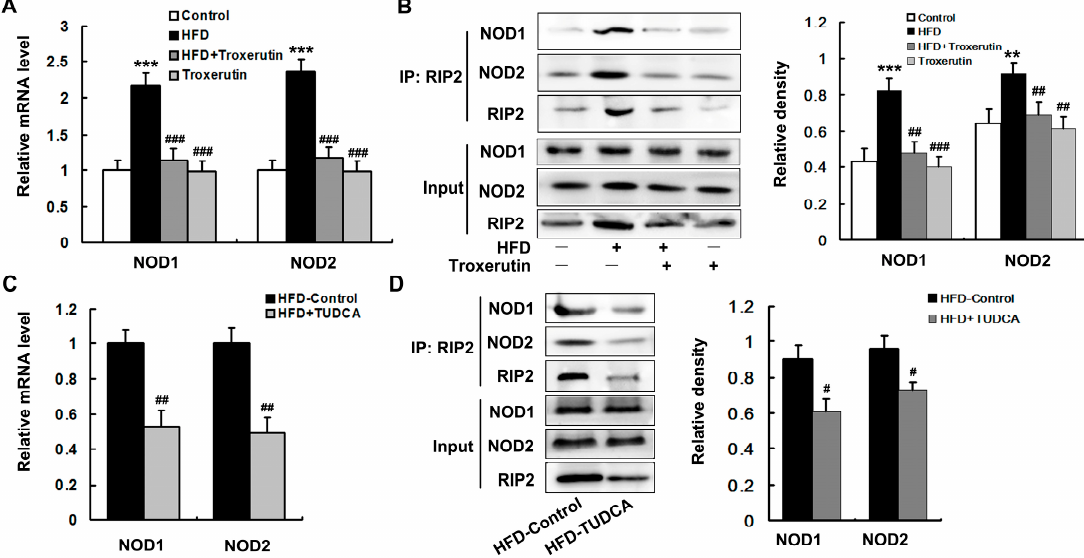
Figure 6. Troxerutin depresses NOD activation in HFD-treated mouse livers ( n = 3). ( A , C ) show the mRNA levels of NOD1 and NOD2 in mouse livers; ( B , D ) show the immunoblotting and densitometry of NOD1 and NOD2 after immunoprecipitation, using RIP2 antibody in mouse livers. All of the values are expressed as the mean ± SD. ** p < 0.01, *** p < 0.001 vs. the control group; # p < 0.05, ## p < 0.01, ### p < 0.001 vs. the HFD group.